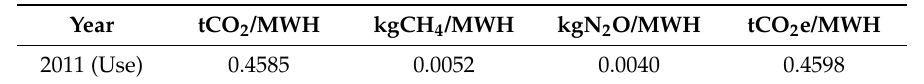
Table 4. GHG emission factors for indirect electric power consumption in 2011 published by the Korea Power Exchange (KPX) [41].